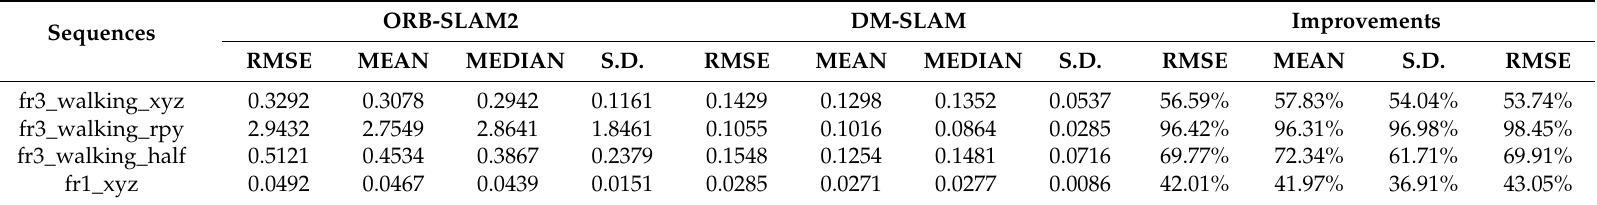
Table 4. Results of metrics absolute trajectory error